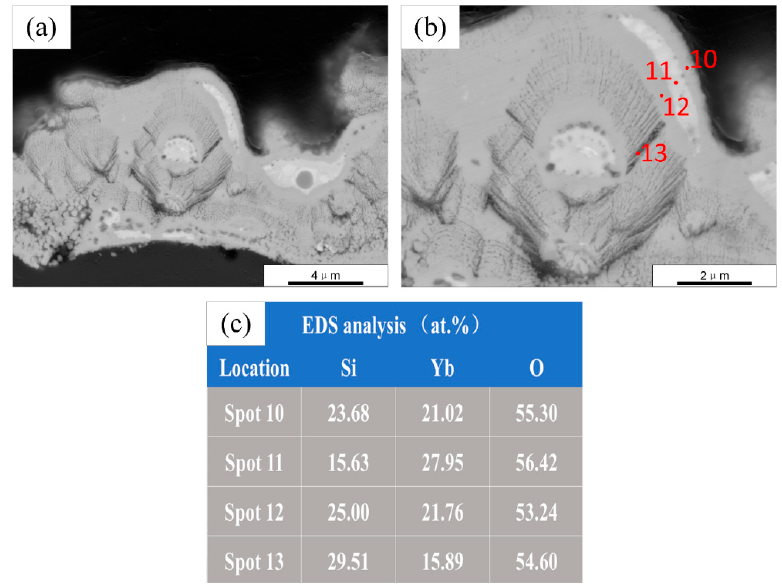
Figure 8. SEM micrographs of annealed ytterbium silicate top-coats prepared by parameter set A: ( a,b ) Cross section by back-scattered electron; and ( c ) EDS analysis of four spots in ( b ).